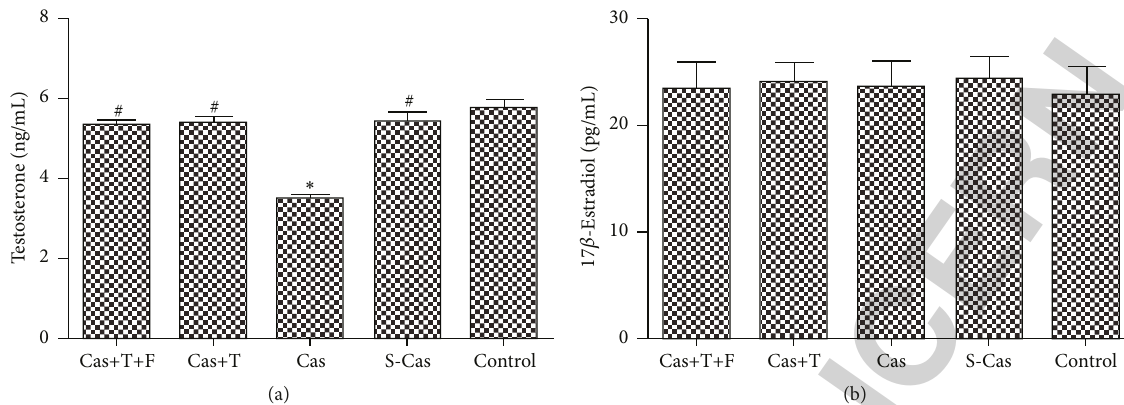
Figure 9: Serum testosterone levels (a) and 17 𝛽 -estradiol levels (b). Values are means ± SD; 𝑛 = 6 . S-Cas: sham-castration; Cas: castration; T: testosterone; F: flutamide. ∗ 𝑃 < 0.001 versus control group; # 𝑃 < 0.001 versus